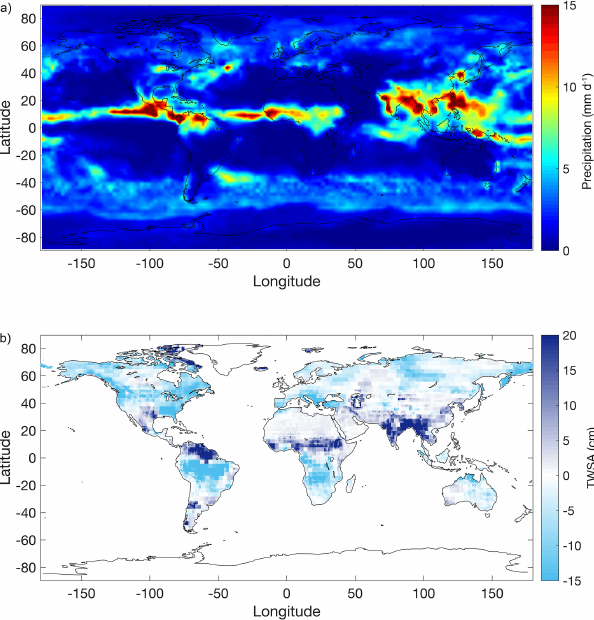
Figure 2. (a) Example of monthly GPCP measurements for Au- gust 2007. (b) Example of monthly GRACE total water storage anomaly (TWSA) measurements for August